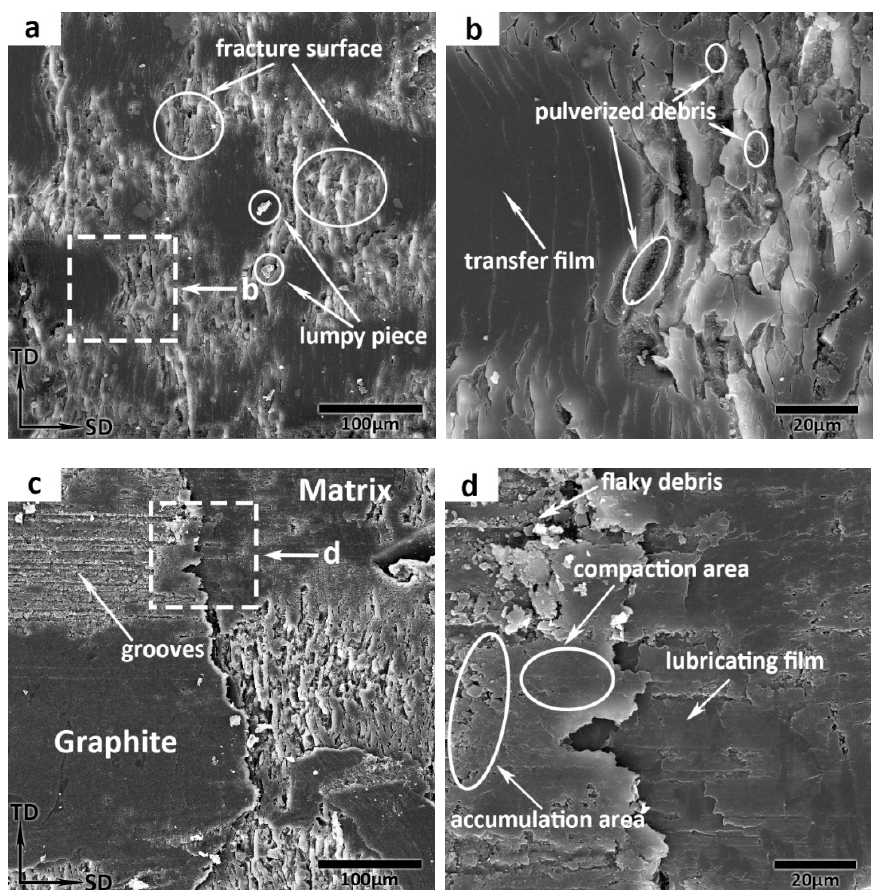
Figure 6. Scanning electron microscope (SEM) images of worn surface at 47.1 m/s: ( a ) Gr-free PF friction composite, ( b ) the zoomed-in views of the rectangular area in ( a ), ( c ) Gr-PF friction composite, ( d ) the zoomed-in views of the rectangular area in ( c ).